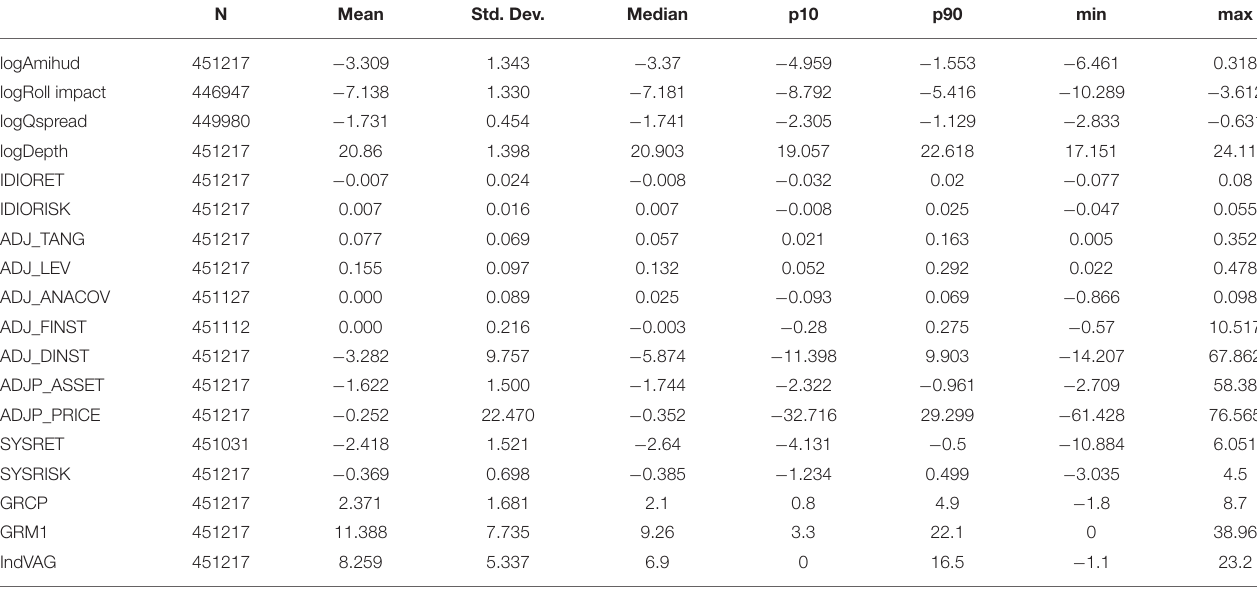
TABLE 1 | Summary statistics.